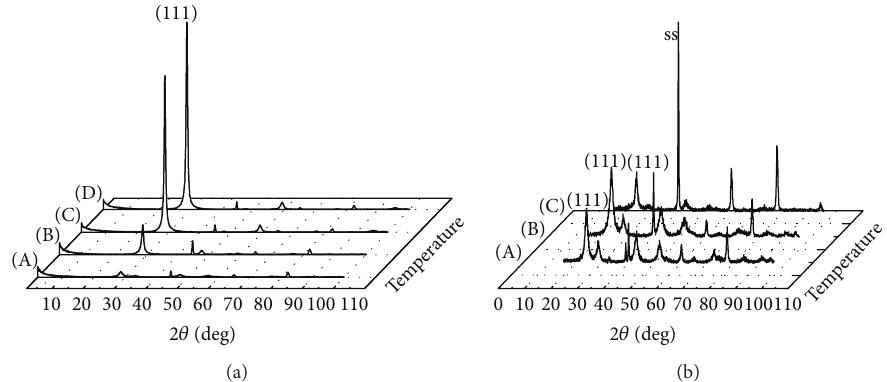
Figure 5: X-ray diffraction patterns of cerium oxide films deposited from a solution of 0.1M Ce(NO 3 ) 3 and 0.1 M acetic acid pH = 7.5, 𝑦 - axis X-ray intensity in cps. (a) Galvanostatic mode: deposition current density of − 0.06mA/cm 2 at (A) 25, (B) 50, (C) 70, and (D) 80 ∘ C. (b) Potentiostatic mode: deposition potential of 1.10V at (A) 25, (B) 50, and (C) 70 ∘ C.